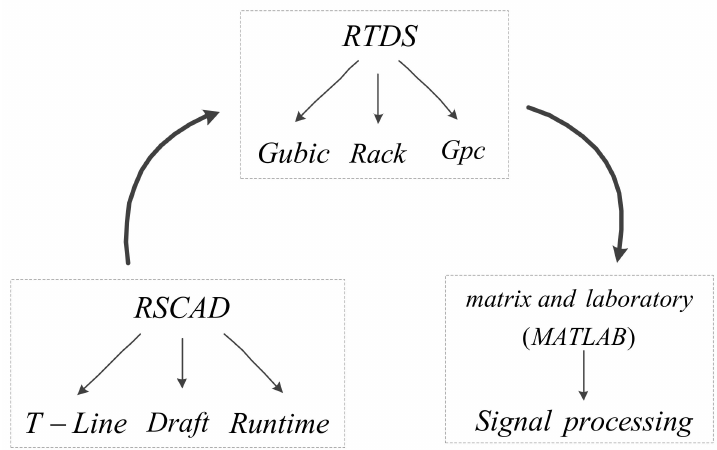
Figure 8. The simulation process of harmonic modeling.